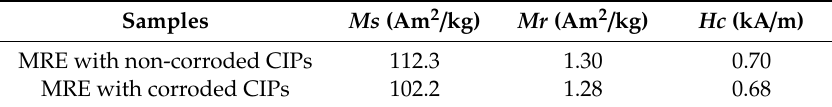
Table 2. Magnetic properties of MRE with non-corroded and corroded